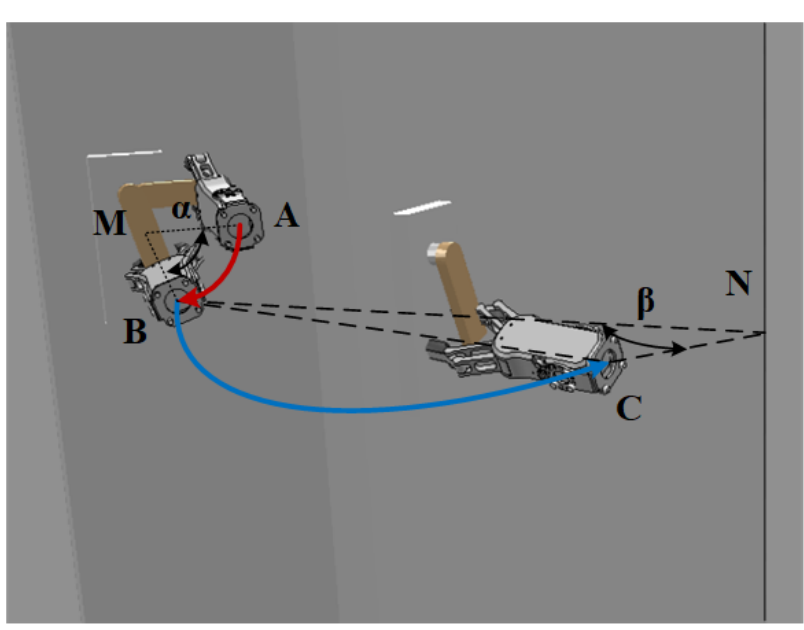
Figure 6. The schematic diagram of the trajectory of the mobile robotic arm.